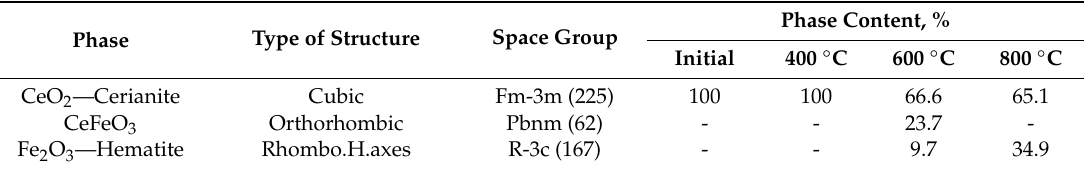
R is the structural coefficient equal to 1.45, I phase is the average integrated intensity of main phase of the diffraction line, I admixture is the average integrated intensity of the additional phase [44]. Table 2 presents data on changes in various contributions depending on the heat treatment temperature. Table 2. Data of phase composition. Table 2. Data of phase